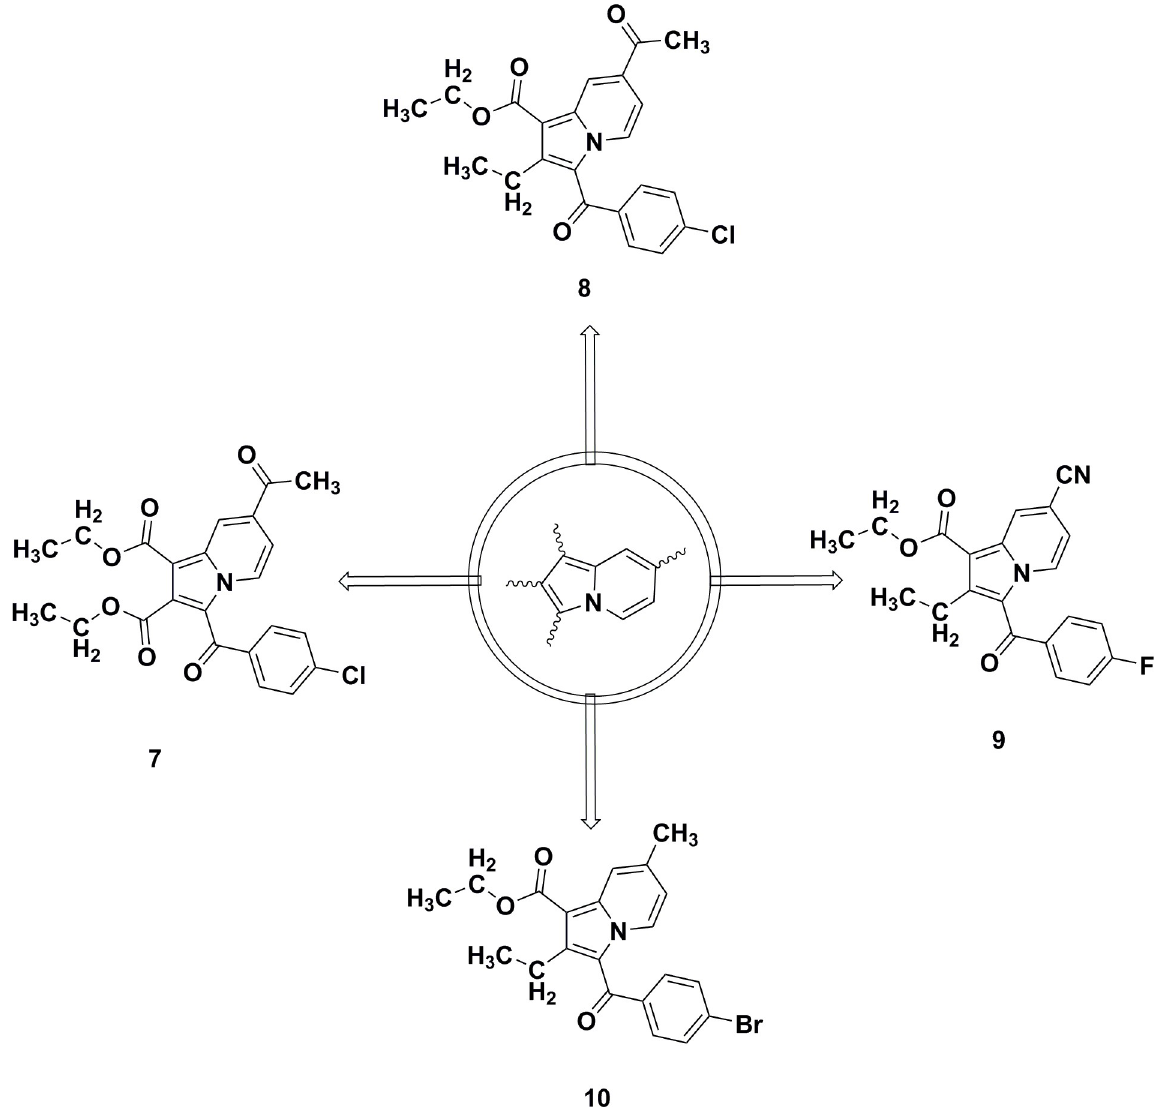
Fig 4. Indolizine lead compounds identified for their anticancer (7) [14] and anti-tubercular (8) properties [10] against MDR strains of MTB, as well as for their COX-2 inhibition (9) [18] and larvicidal activity (10) [25] against Anopheles arabiensis